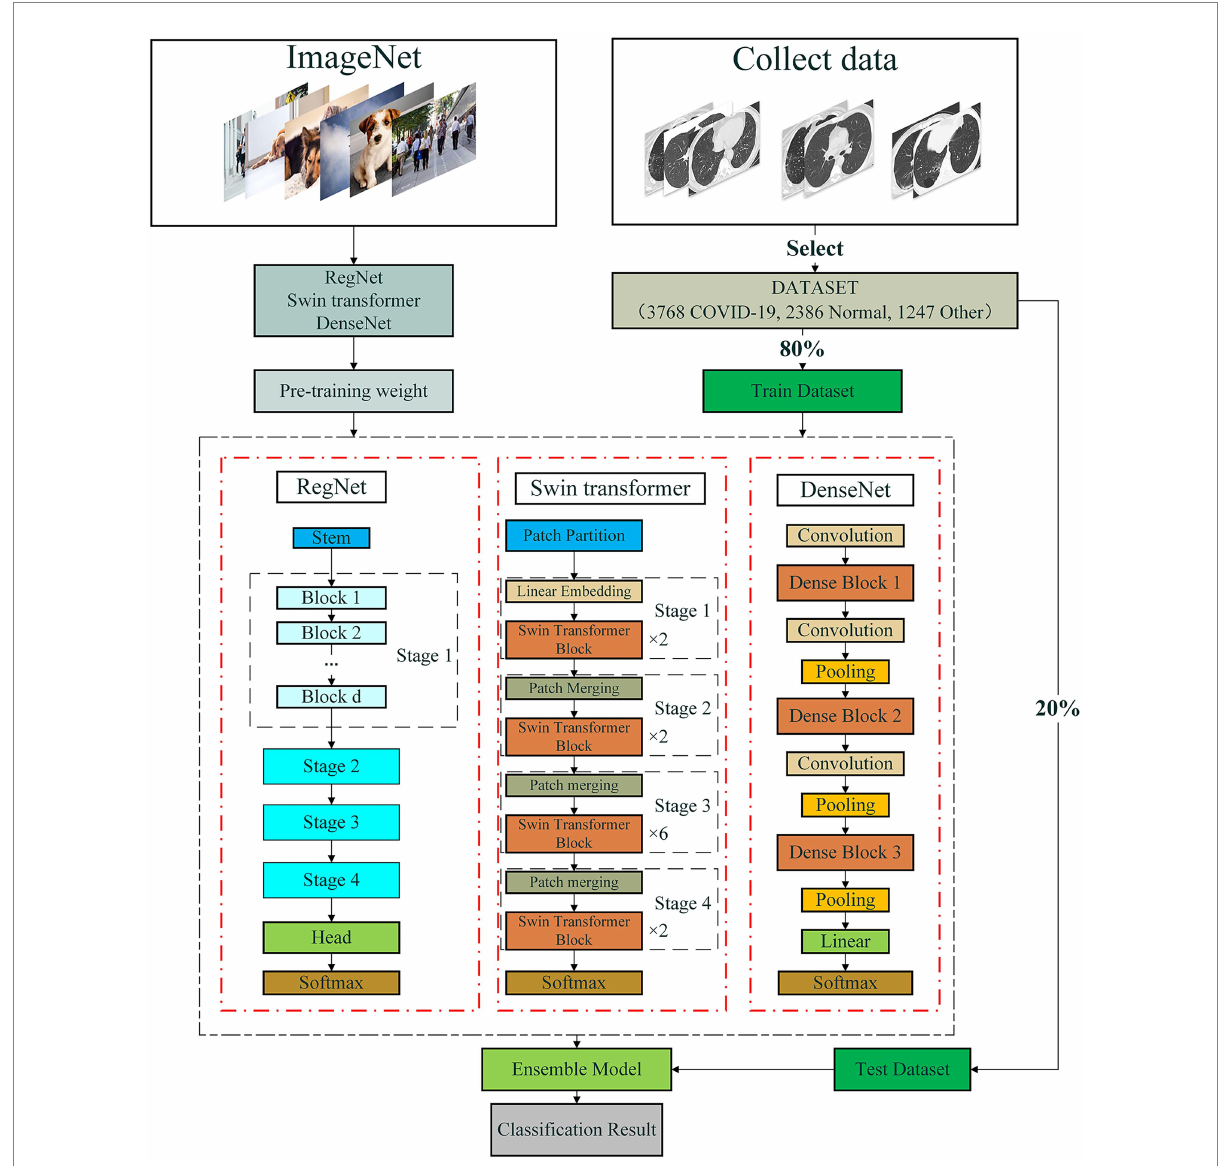
FIGURE 2 The pipeline for COVID-19-related CT image classification based on an ensemble of DenseNet, RegNet, and Swin